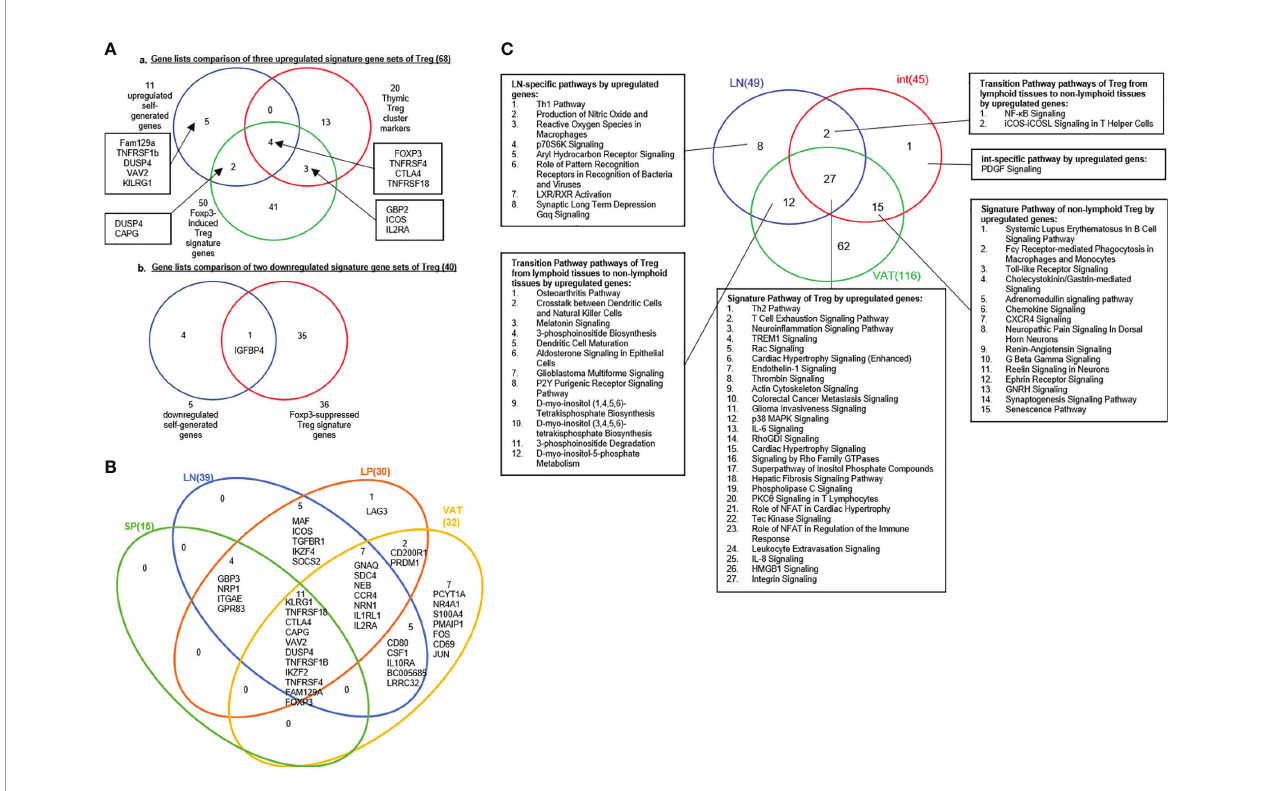
FIGURE 3 | (A) A new 68 upregulated signature genes are identi fi ed in Treg: 11 upregulated genes in our fi nding, 20 thymic Treg cluster markers were identi fi ed based on single cell-sequence by S A Teichmann (PMID: 32079746) and 50 Foxp3-induced Treg signature genes (PMID: 28892470). Venn diagram showed that FOXP3, TNFRSF4, CTLA4, TNFRSF18 were common signature genes which could be upregulated in Treg; IGFBP4 was shared by downregulated gene set we generated and 36 Foxp3-suppressed Treg signature genes. (B) Venn Diagram showed shared consistent upregulated signature genes in four tissues we